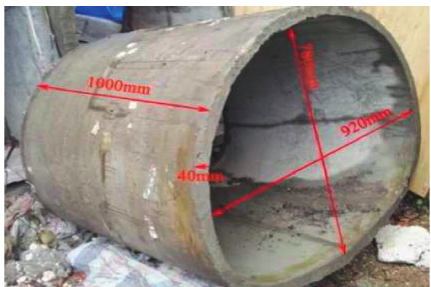
Figure 10: Oval tunnel lining model.